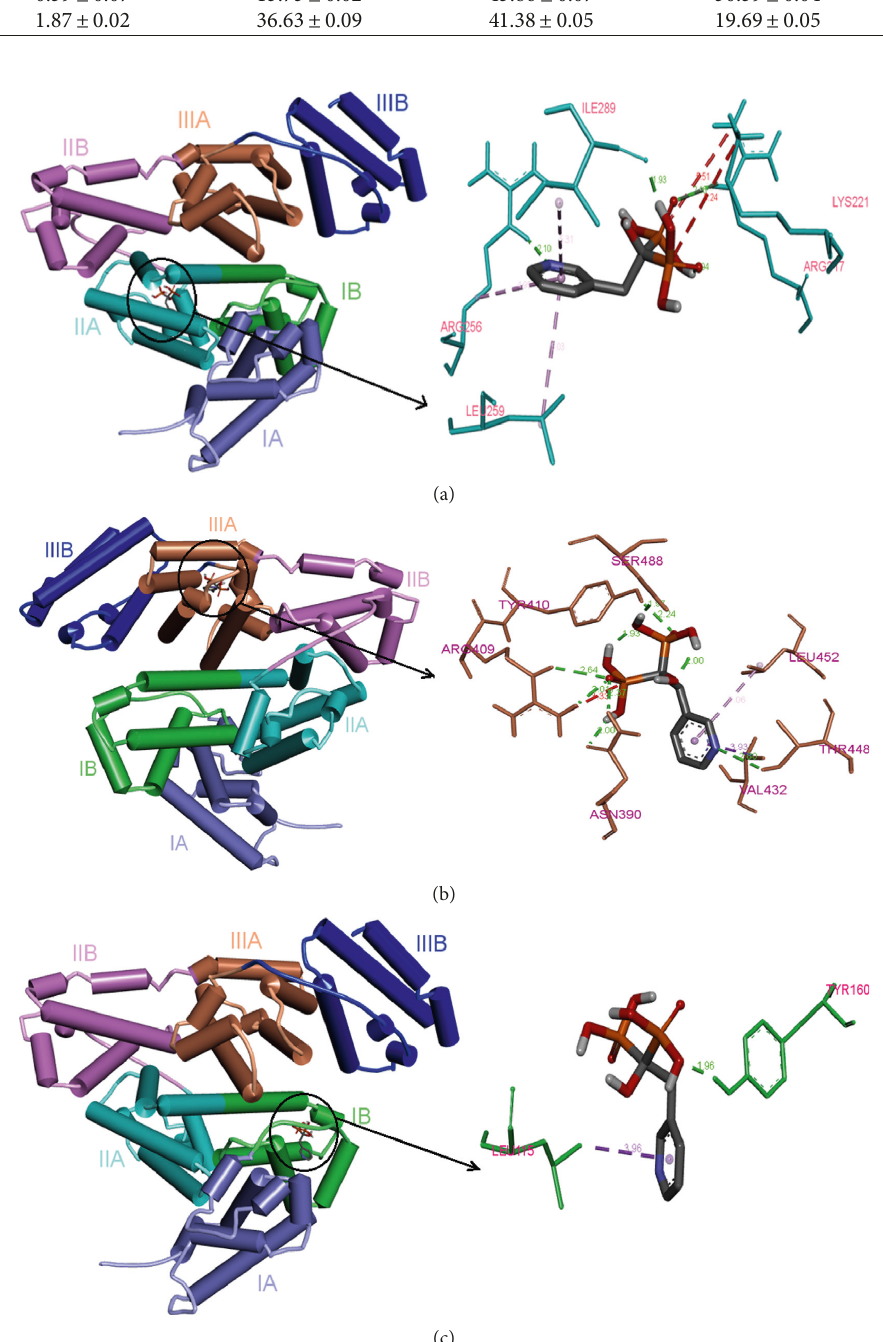
Figure 10: The molecular binding interaction of BSA and RSN for the three binding sites I (IIA), II (IIIA), and III (IB) by molecular docking